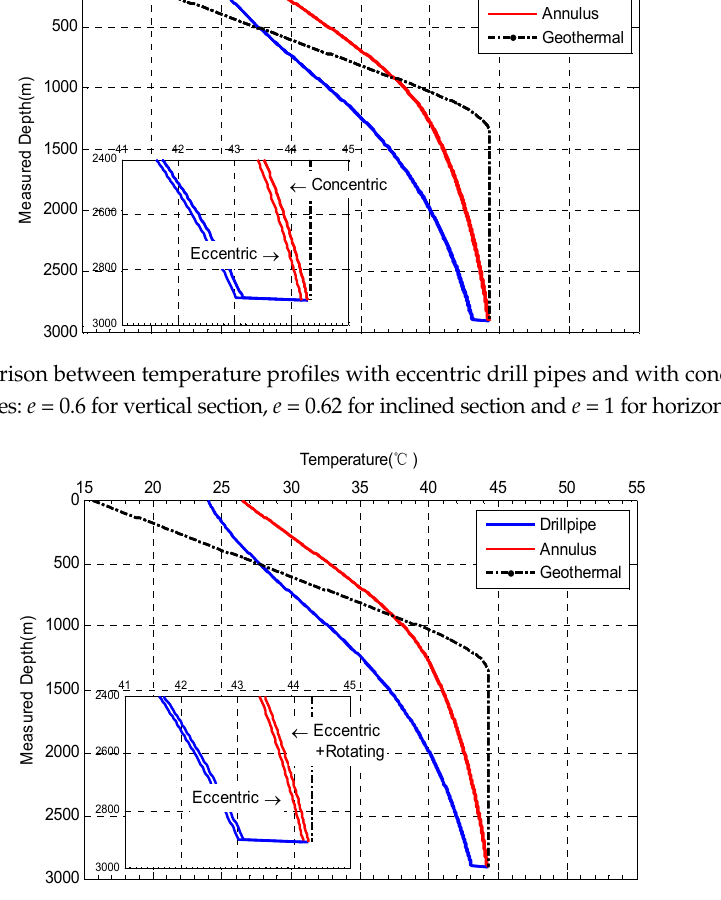
Figure 7. Comparison between temperature profiles under eccentric conditions in drill pipes with and without rotations (RPM = 100 r/min).